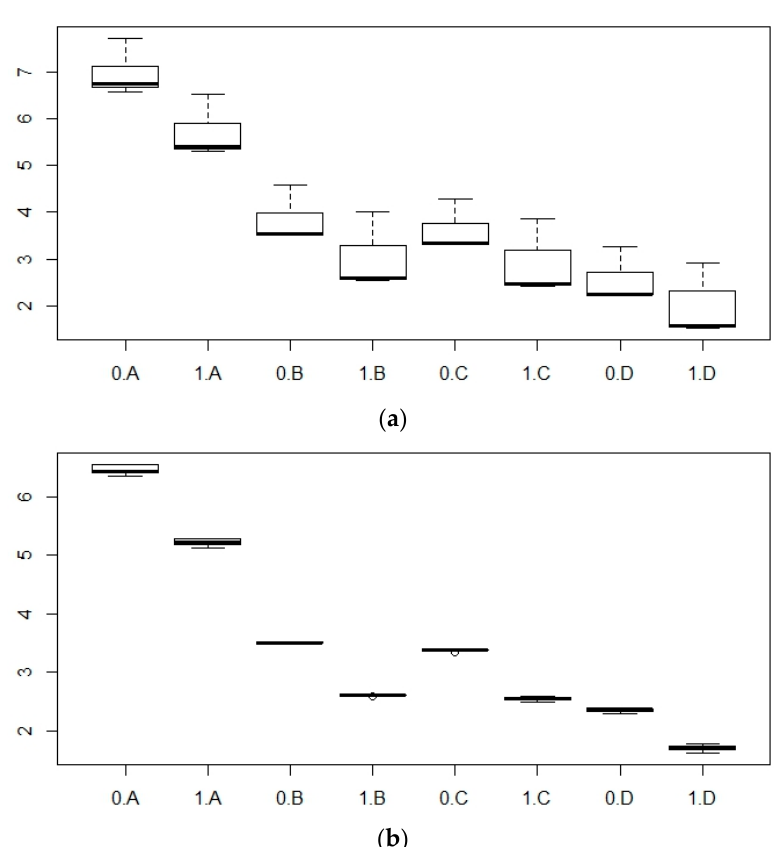
Figure 7. Boxplots for the mean concentrations of phytoplankton in the basin ( a ); in the channel ( b ). A–D refer to the PAR scenarios (as in Figure 4) and 0 and 1 to the scenarios without (0) and with (1) an array of TEDs. 0. A hence refers to PAR scenario A without turbines.